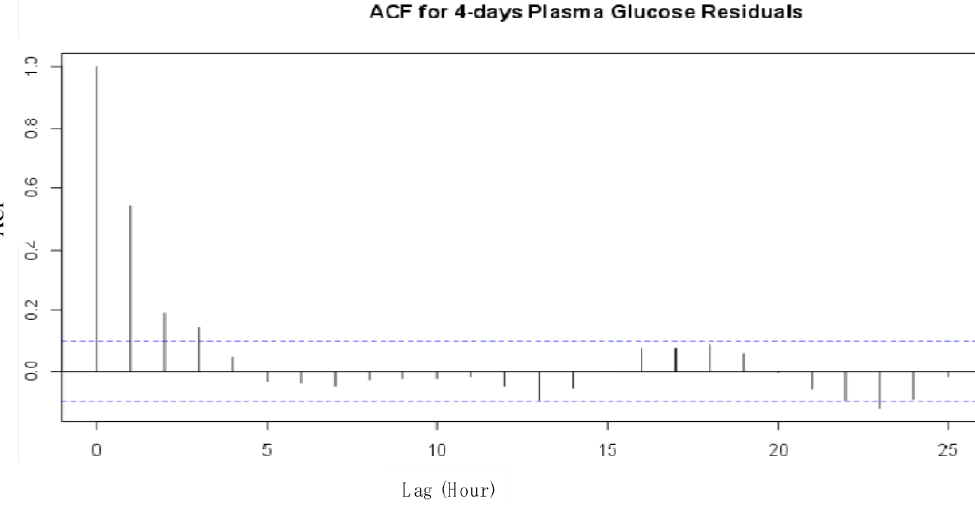
Figure 4. ACF for four consecutive days’ plasma glucose residuals from the SDE